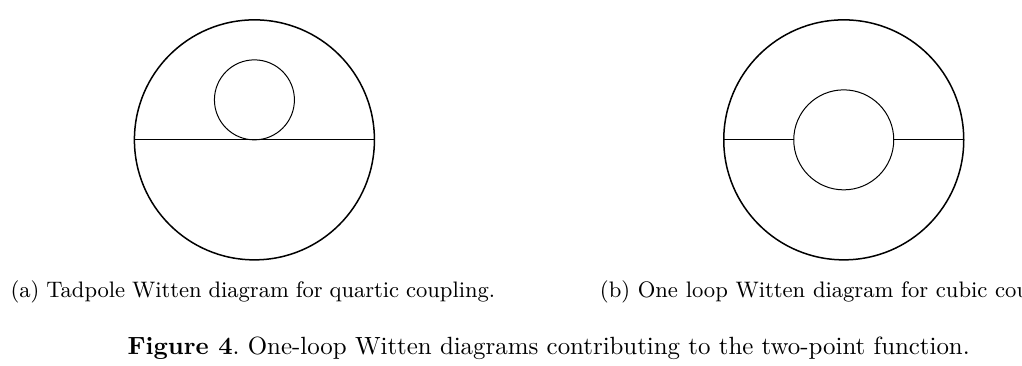
Figure 4 . One-loop Witten diagrams contributing to the two-point